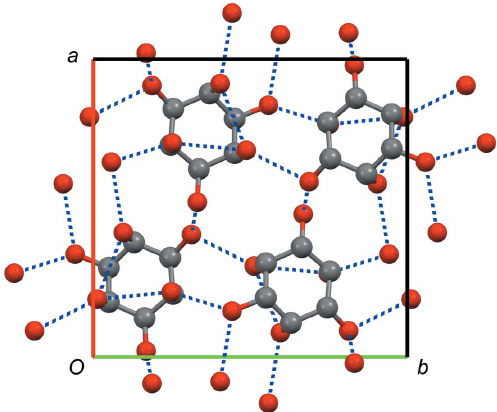
Figure 13 Crystal structure of 5 -A. Space group P 2 1 / n , view along the c axis ( a axis shown in red, b axis shown in green). Hydrogen bonds are indicated as dashed blue lines, H atoms have been omitted for clarity.